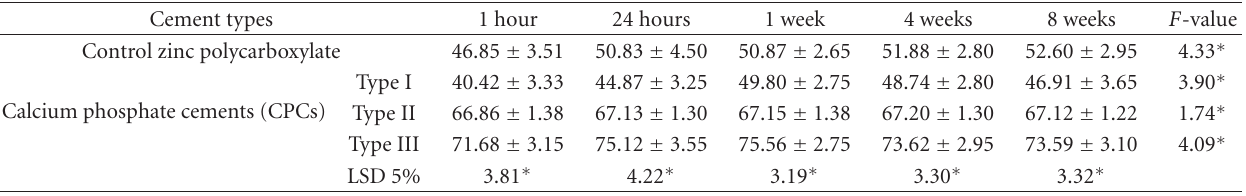
Table 3: Mean compressive strength and standard deviation of zinc polycarboxylate cement and the three polymeric calcium phosphate cements (CPCs) in MPa.